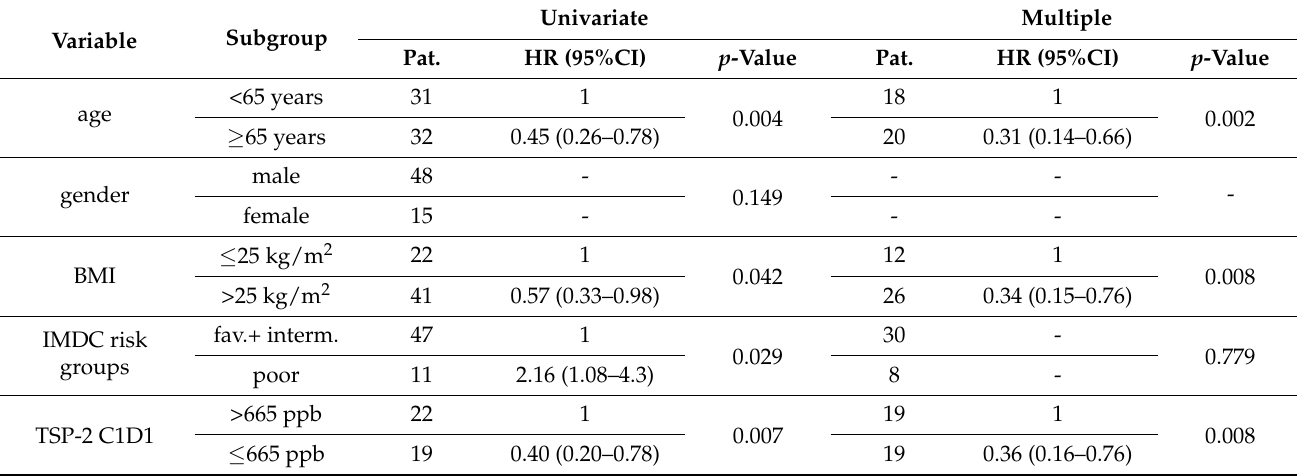
Table 2. Univariate and multiple Cox regression analysis to compare the impact of pre-specified patient groups and the exploratory biomarkers at baseline on the progression-free survival. The number next to each group indicates the quantity of patients included within the corresponding